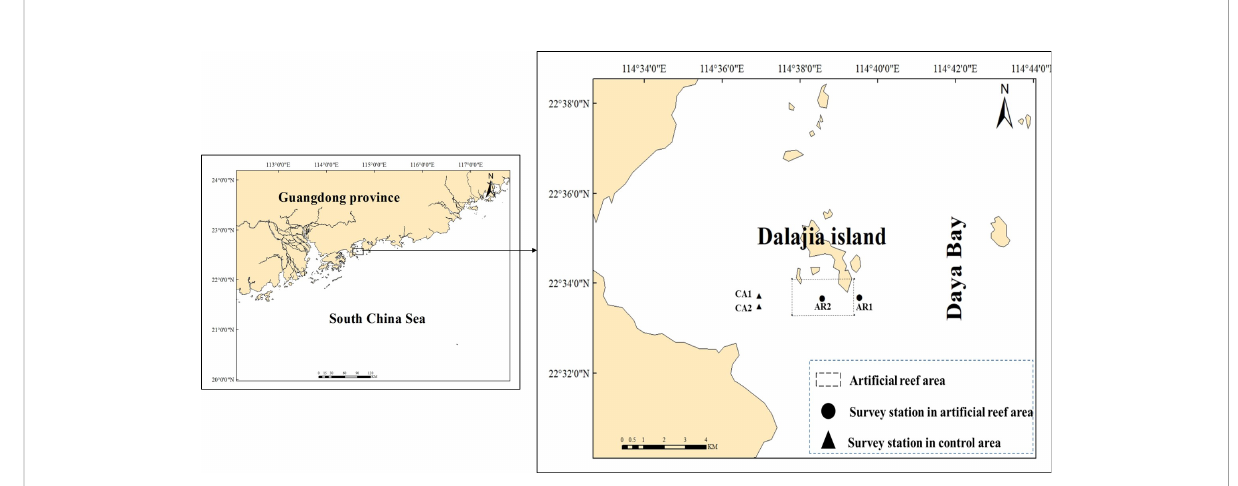
FIGURE 1 Locations of the two habitats studied in Dalajia, Daya Bay, China. AR, arti fi cial reef habitat; CA, area near AR habitat without arti fi cial